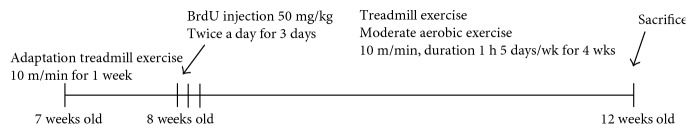
Experimental design of the present study. Treadmill exercise was adopted in 7-week-old mice for 1 week, and treadmill exercise was conducted for 4 weeks with 10 m/min speed for 1 h. During the first 3 days of exercise, BrdU was injected twice a day (at 8:00 AM and 8:00 PM) intraperitoneally to label newborn neural stem cells.